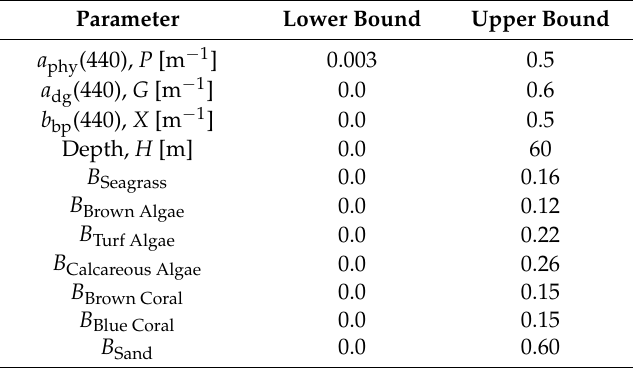
Table 3. Optimization